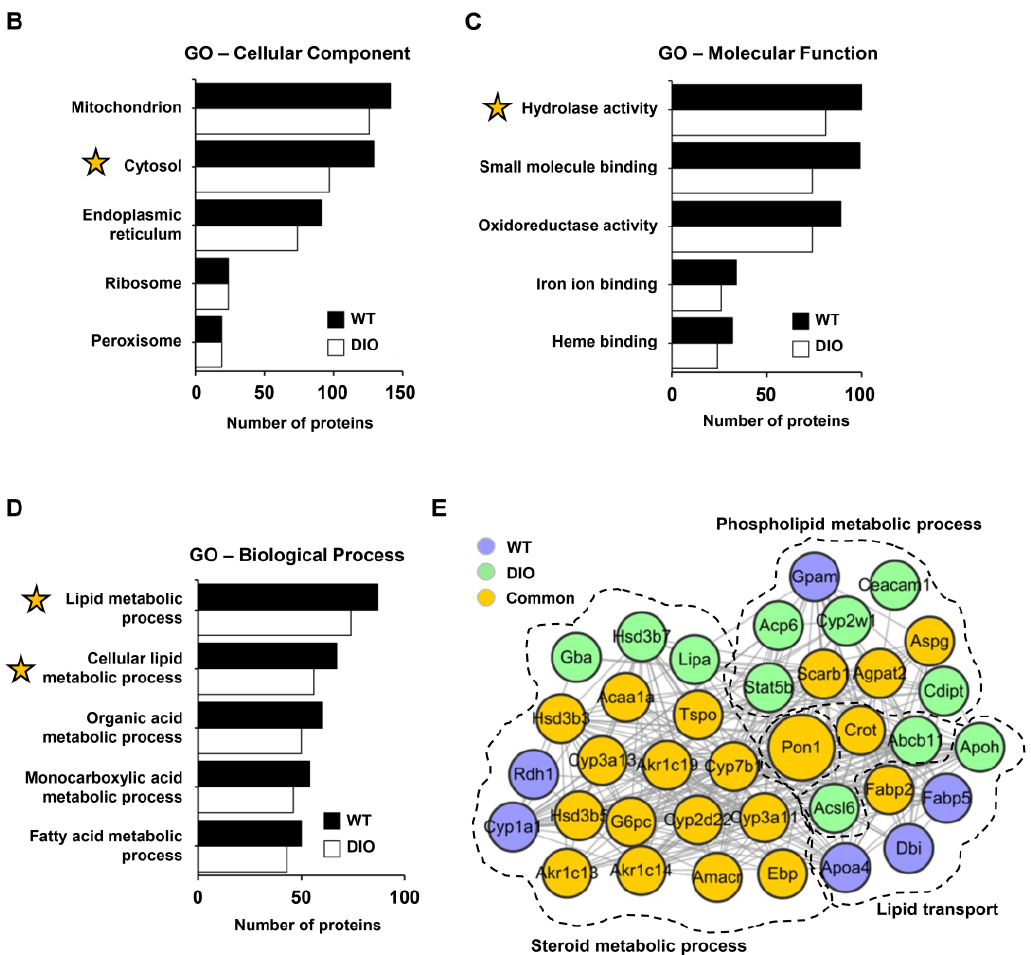
Figure 1. PON1 is identified as a potential target of vutiglabridin through NPOT assay. ( A ) Schematic representation of the Nematic Protein Organization Technique (NPOT) analysis of vutiglabridin on protein homogenates from the liver of healthy wild-type (WT) and diet-induced obesity (DIO) mice with validation by biophysics methods. In total, 568 proteins were identified as potentially interacting proteins, and 296 proteins (52%) were present in both conditions. ( B ) Ranked list of Gene Ontology (GO) cellular components and ( C ) molecular functions of the identified proteins in both conditions. ( D ) Ranked list of Gene Ontology biological processes of the identified proteins in both conditions with hydrolase activity as the molecular function. X -axis shows gene count. Yellow star marks the inclusion of PON1 protein. ( E ) The interactome network of 37 proteins that are involved with phospholipid metabolic process, steroid metabolic process, and lipid transport, which are downstream of the molecular function of lipid metabolic process. PON1 is identified as the central protein involved in all three